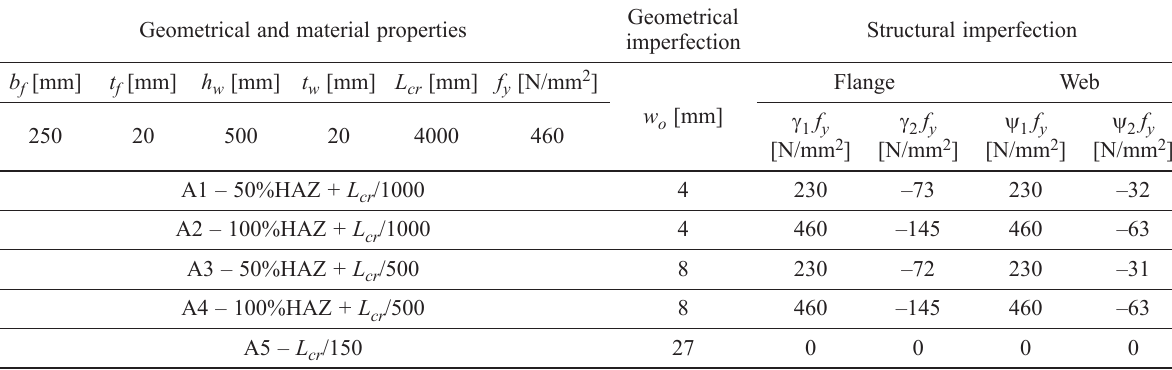
table 2. Geometrical and structural imperfection of the analysed column Geometrical and material